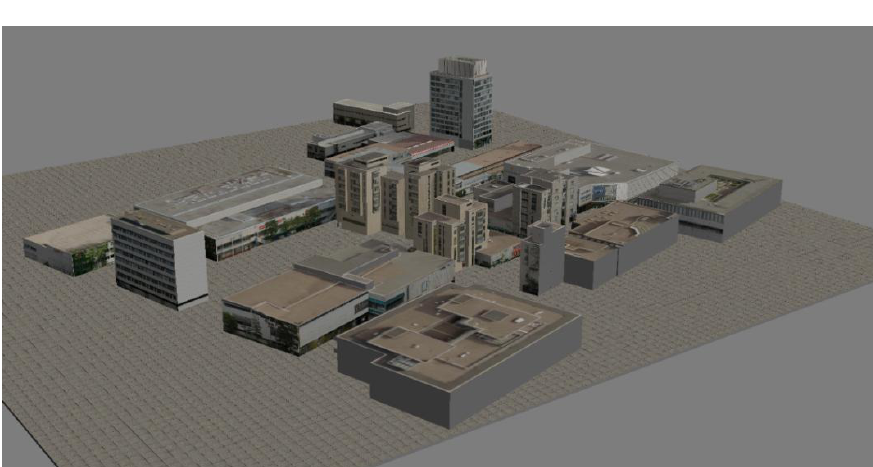
Figure 16. 3D models of